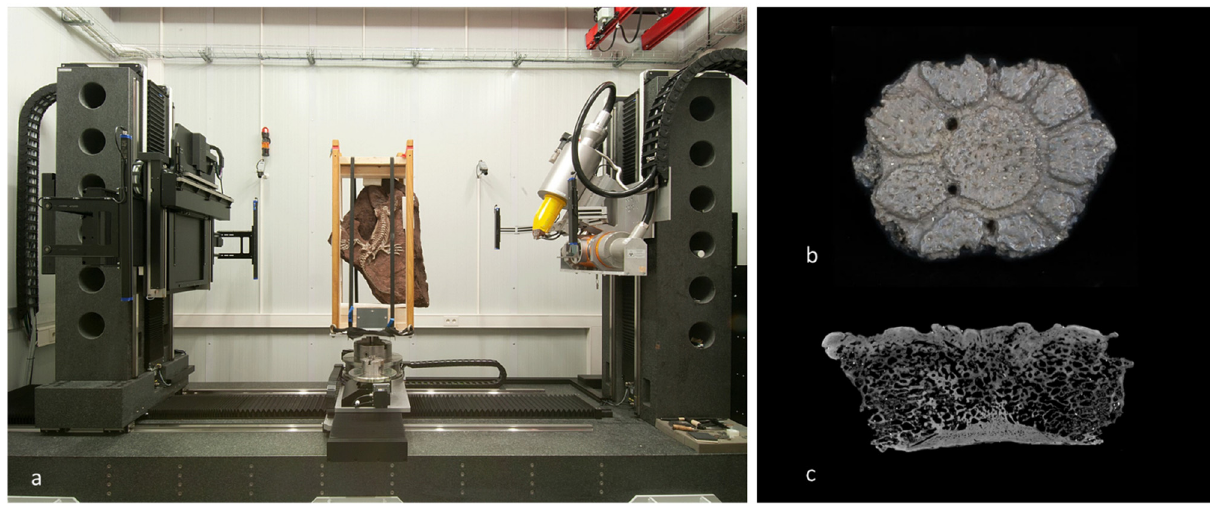
Figure 2. Virtual palaeontology: Computed Tomography. ( a ) Orobates fossil CT scan. Image courtesy of Tanja Kirsten, Technische Universität, Dresden and John A. Nyakatura, Humboldt University, Berlin. Osteoderm in ( b ) dorsal view and ( c ) Micro-CT scan transversal view. Image courtesy of Chris Broeckhoven, European Space Agency, ACT, Netherlands, and Anton du Plessis, Object Research Systems, Montreal, Canada.